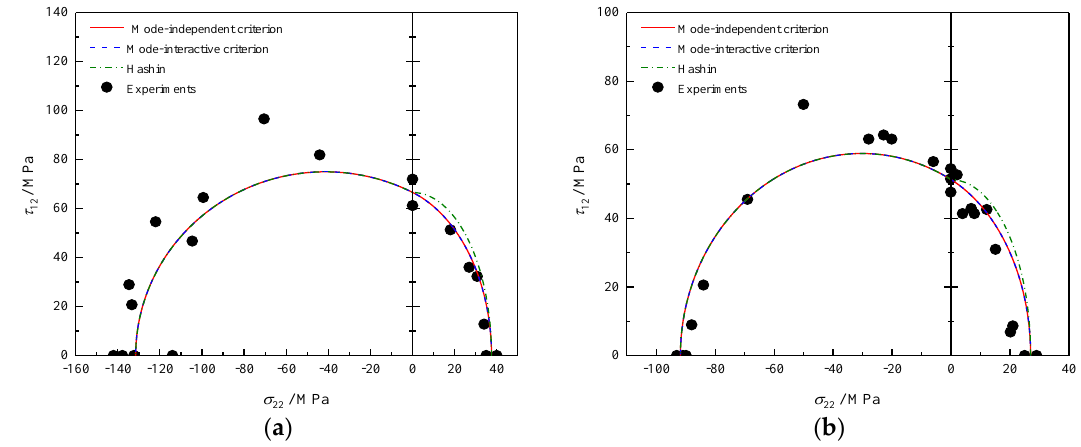
-   for ( a ) E-glass/ LY556 and ( b ) 22 12